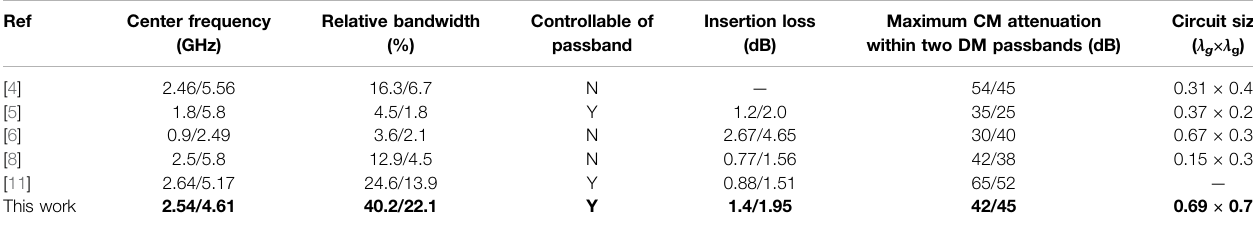
TABLE 1 | Comparison of some previous dual-band balanced/differential fi lters.